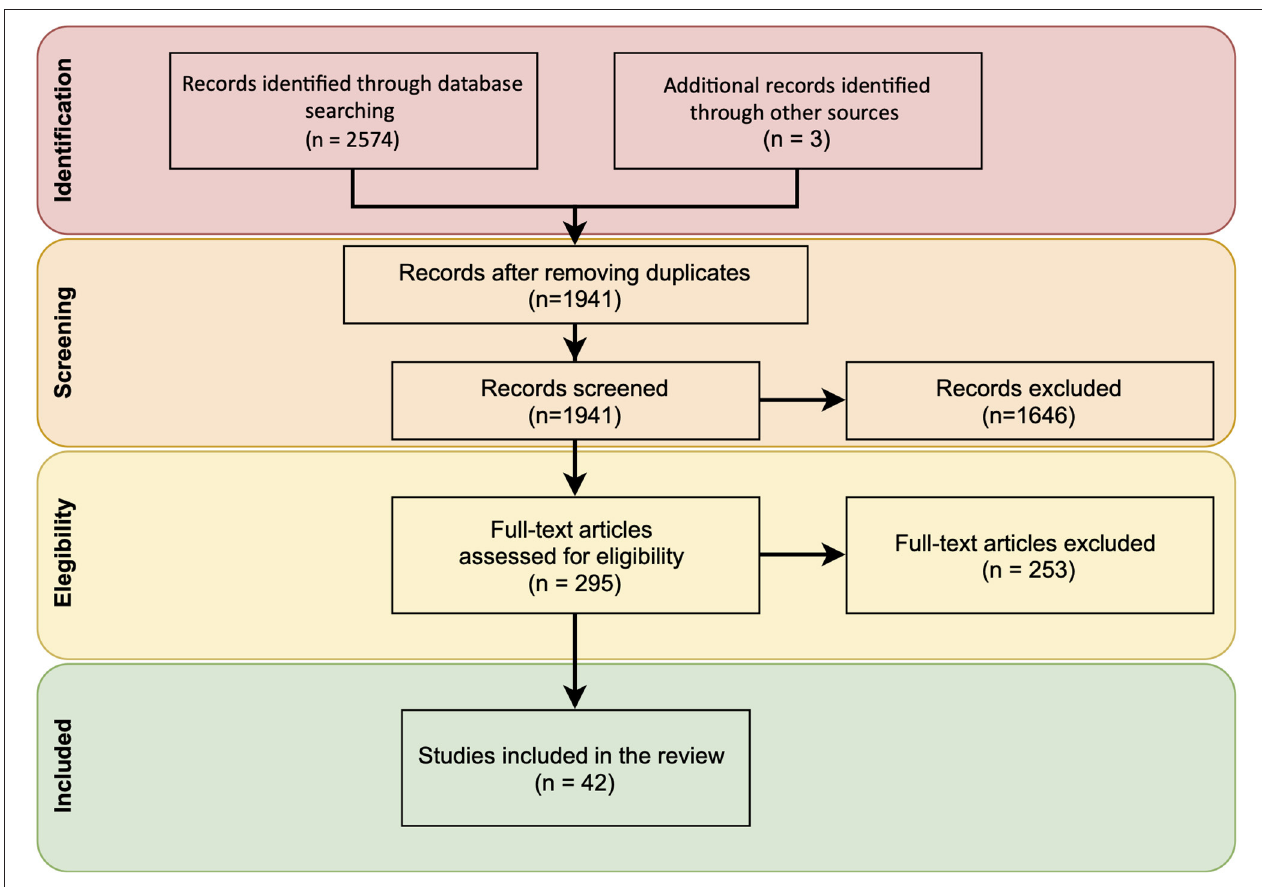
FIGURE 1 | Flow diagram of studies through the review